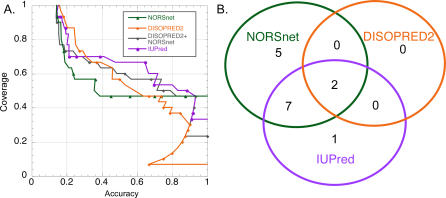
Predictions for NESG Data(A) The NESG set contains many proteins with unstructured regions that are not in DisProt and have never been used for method optimization. We compared NORSnet (in green), DISOPRED2 (in orange), their combined method (in gray), and IUPred (in purple) on these proteins. While DISOPRED2 performed better than all other methods in the low accuracy/high coverage region (top left), the combined method, NORSnet, and IUPred individually excelled in the high accuracy/low coverage region (lower right).(B) Venn diagram of overlap between very accurate predictions by NORSnet, DISOPRED2, and IUPred. The numbers in the circles are mutually exclusive. Note that five proteins were identified only by NORSnet to have an unstructured region.